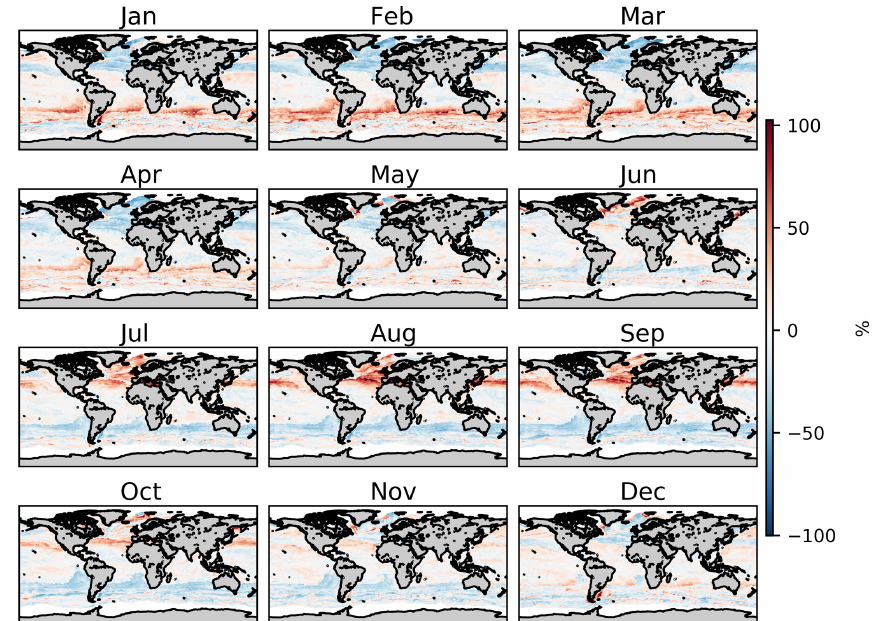
Figure A3. Percentage difference in monthly sea-surface iodide from the annual mean field predicted by the 10-model member ensemble. Only locations that are entirely water are included. Earth raster and vector map data used are freely available from Natural Earth (http: //www.naturalearthdata.com/, last access: 23 July 2019).